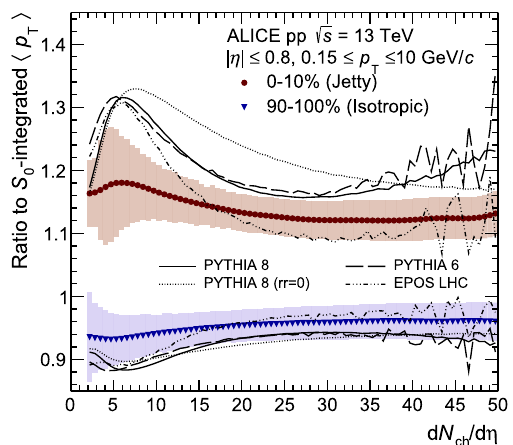
Fig. 9 Average p T of jet-like (circles) and isotropic (triangles) events normalized to that for the spherocity-integrated event class. The mea- surements are compared with different Monte Carlo generators. Sta- tistical uncertainties (error bars) are negligible compared to systematic uncertainties (boxes around the data